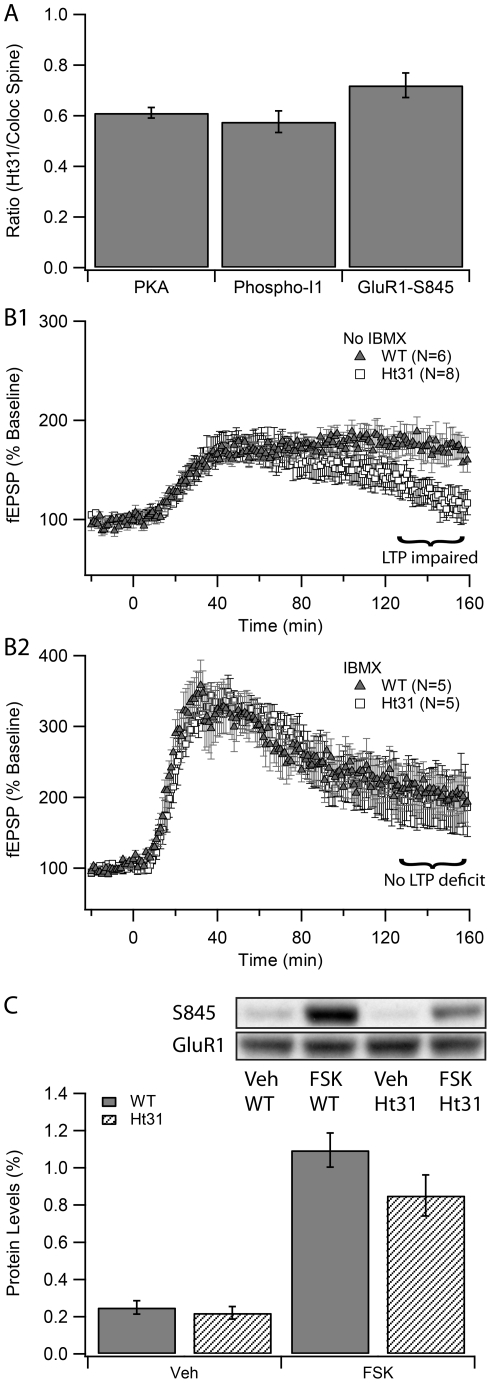
Evaluating the role of Ht31 on synaptic plasticity.(A) Ht31 disruption of PKA anchoring decreases PKA activity and phosphorylation of downstream targets in the model. The decrease in PKA activity (PKA catalytic subunit, quantity of phospho-inhibitor-1, or fraction of phospho-GluR1-S845) is quantified as ratio of those values when PKA is diffusely distributed versus colocalized with adenylyl cyclase in the spine head. (B) Experimental test of model prediction. Long-lasting synaptic potentiation is induced using forskolin (50 µM), which is delivered for 15 minutes after 20 minute baseline recording. (B1) Forskolin-induced synaptic potentiation is impaired in mice expressing Ht31. The maintenance of synaptic potentiation is impaired 2 hours after the drug treatment in Ht31 (squares) compared with wildtype (triangles) (p = 0.012). (B2) The impairment in forskolin induced potentiation is rescued in the presence of IBMX, which inhibits phosphodiesterases. There is no difference in fEPSP between Ht31 and wildtype animals 2 hours after drug treatment (p = 0.65). (C) Forskolin-induced S845 phosphorylation is impaired in mice expressing Ht31. Representative blots for S845 and GluR1 are shown at the top. The bottom graph shows the mean quantity of phosphorylated S845 on GluR1, normalized by dividing by the total GluR1 levels. Ht31 expression did not affect basal S845 phosphorylation (p = 0.79, N = 10 per genotype). In contrast, forskolin induced S845 phosphorylation was reduced in mice expressing Ht31 (p = 0.03, N = 10 per genotype).